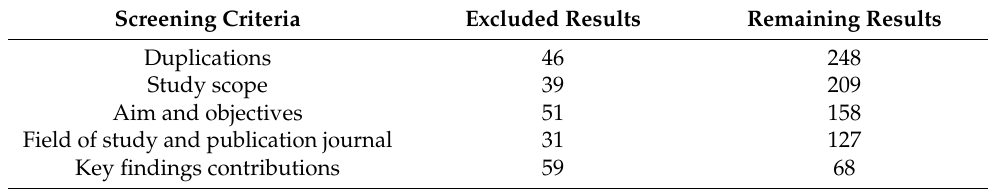
Table 2. Literature